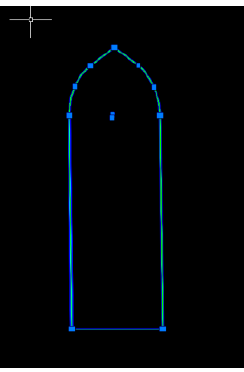
Figure 7. An example of window drawing with vertices, which is used to determine the window